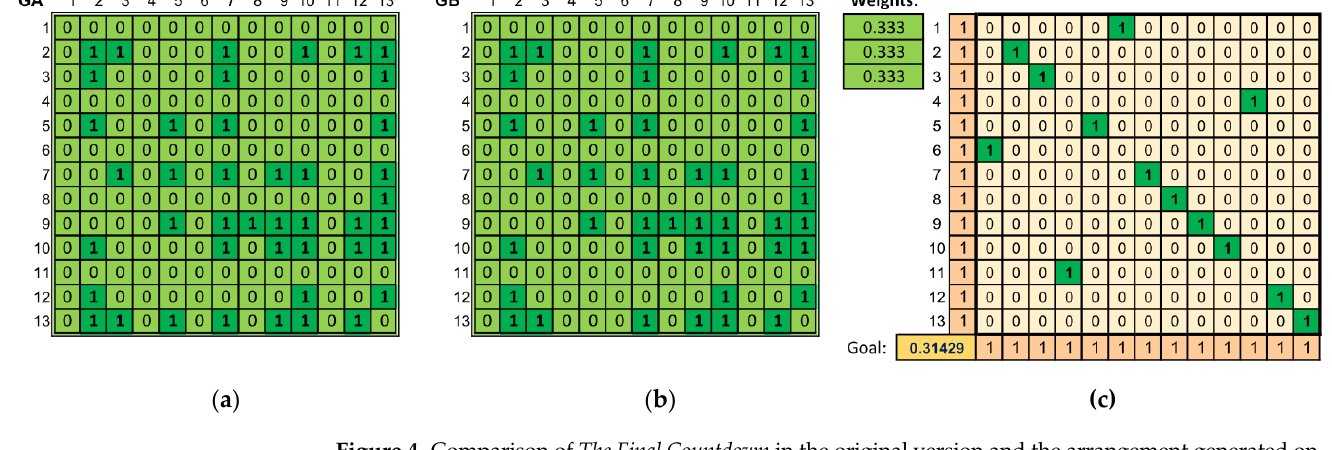
Figure 4. Comparison of The Final Countdown in the original version and the arrangement generated on its basis. ( a ) The adjacency matrix of the graph representing the original piece. ( b ) The adjacency matrix of the graph representing the arrangement. ( c ) The calculated assignment matrix of vertices from one graph to another (maximizing graph similarity) together with the value of the objective function.